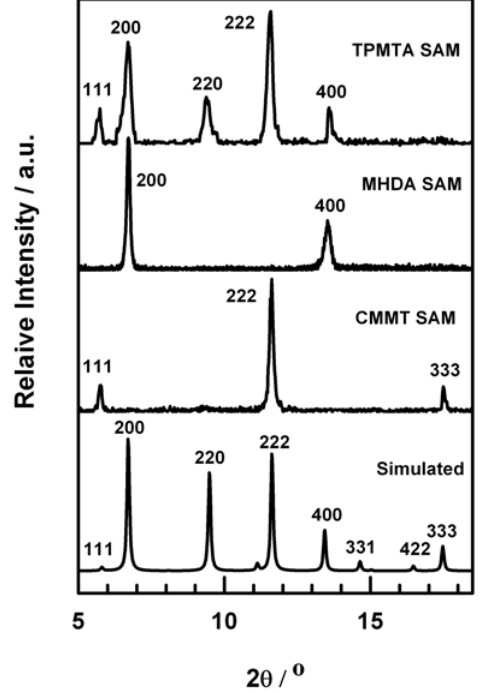
Figure 2. X-ray diffraction patterns (background corrected) thin films of HKUST-1 on various carboxylic groups functionalized gold surfaces after 40 deposition cycles. The patterns are compared with a simulated powder reference sample. Each pattern is normalized to the most intense